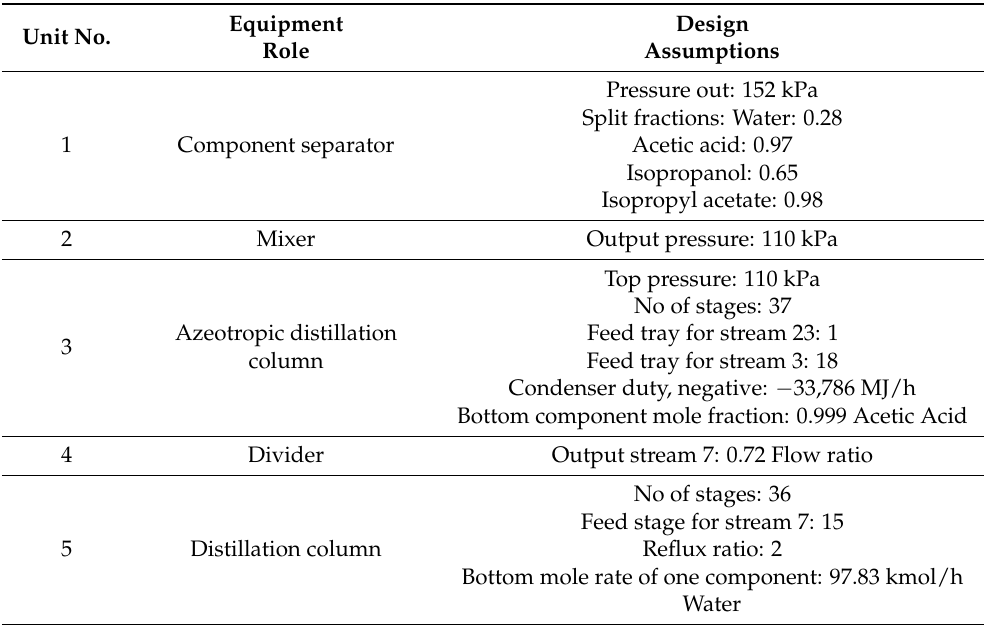
Table 3. Design assumptions of the main units for case 3. Unit